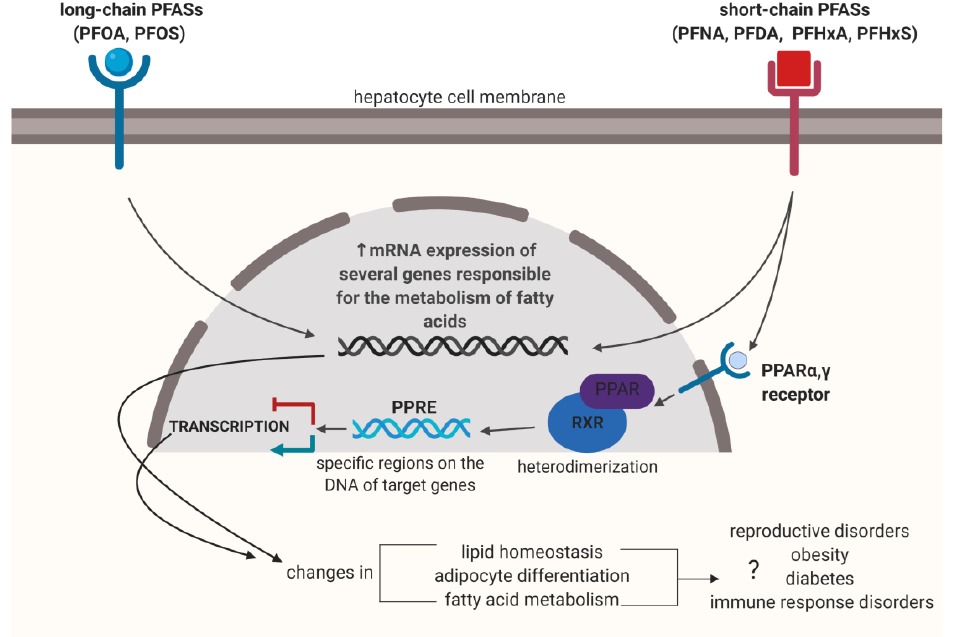
Figure 3. Potential molecular mechanism of PFASs hepatotoxicity. In liver cells, PFASs activate peroxisome-proliferator-activated receptor (PPAR), which induces heterodimerization with retinoid x receptor (RXR). Complex binds to specific sequence of DNA–PPREs (peroxisome-proliferator hormone-response elements), which occurs in the promoter region of a gene and modulate transcription. Based on papers of Reference [170].